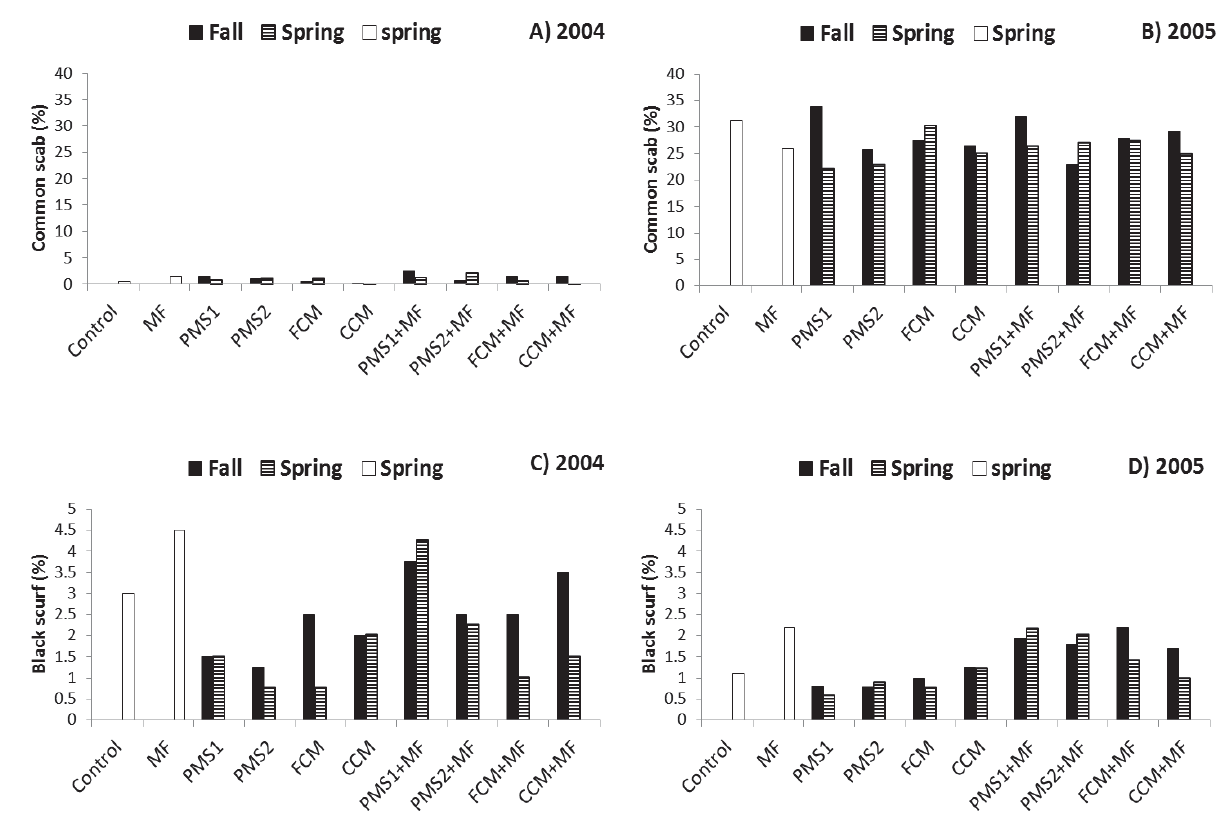
Figure 4. Effects of mineral N fertilization and organic amendments with or without supplemental N fertilizer (N) on common scab ( A , B ) and black scurf ( C , D ) in 2004 and